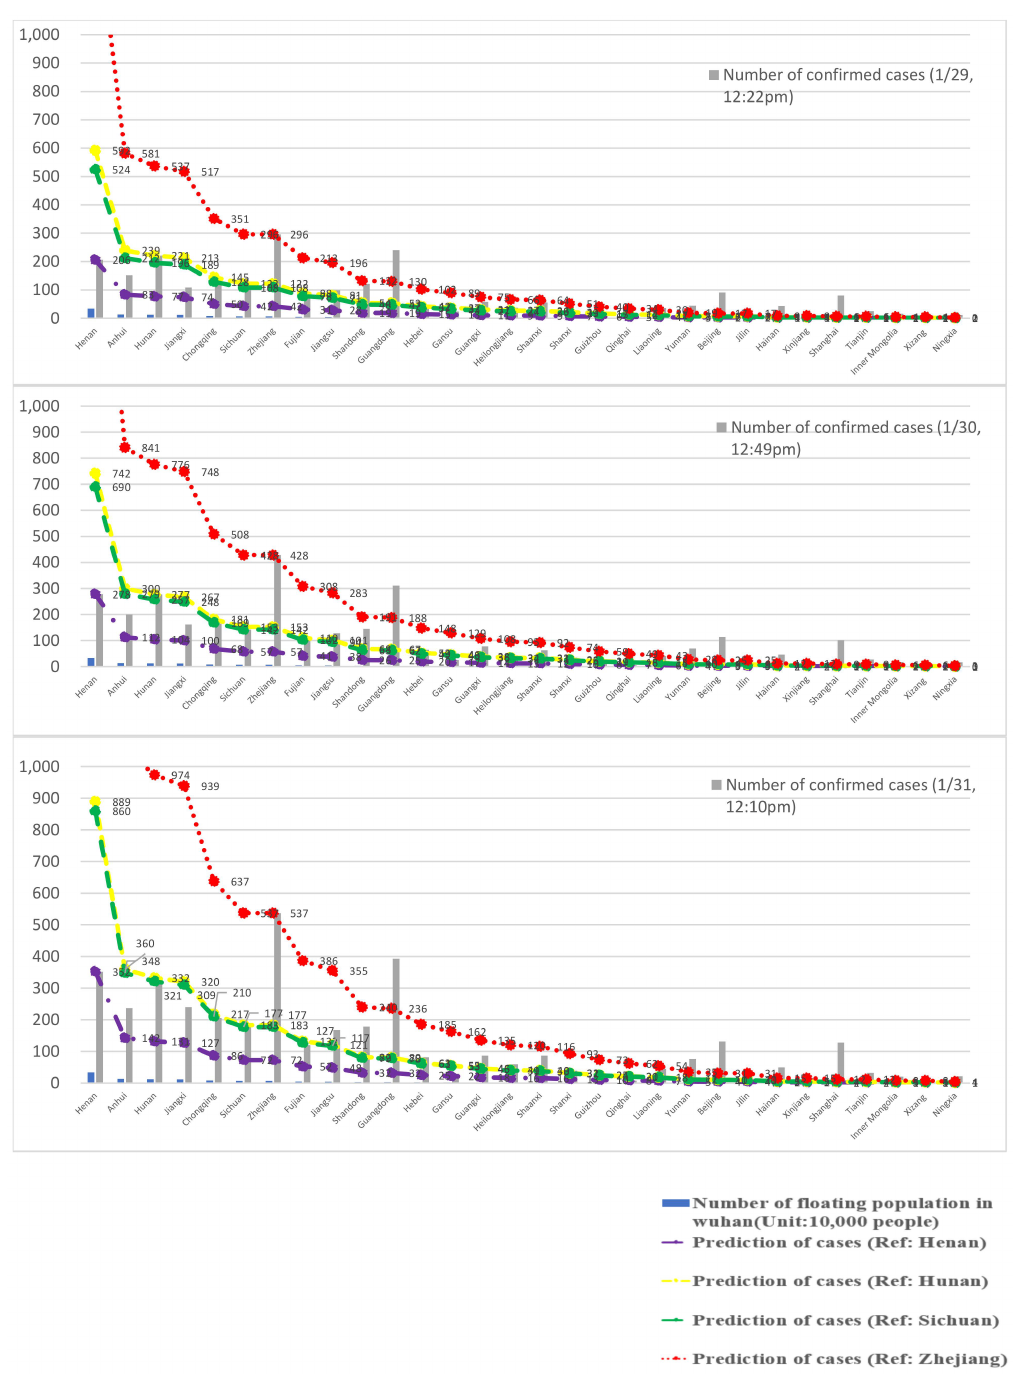
Figure 4. Prediction of the epidemic situation in